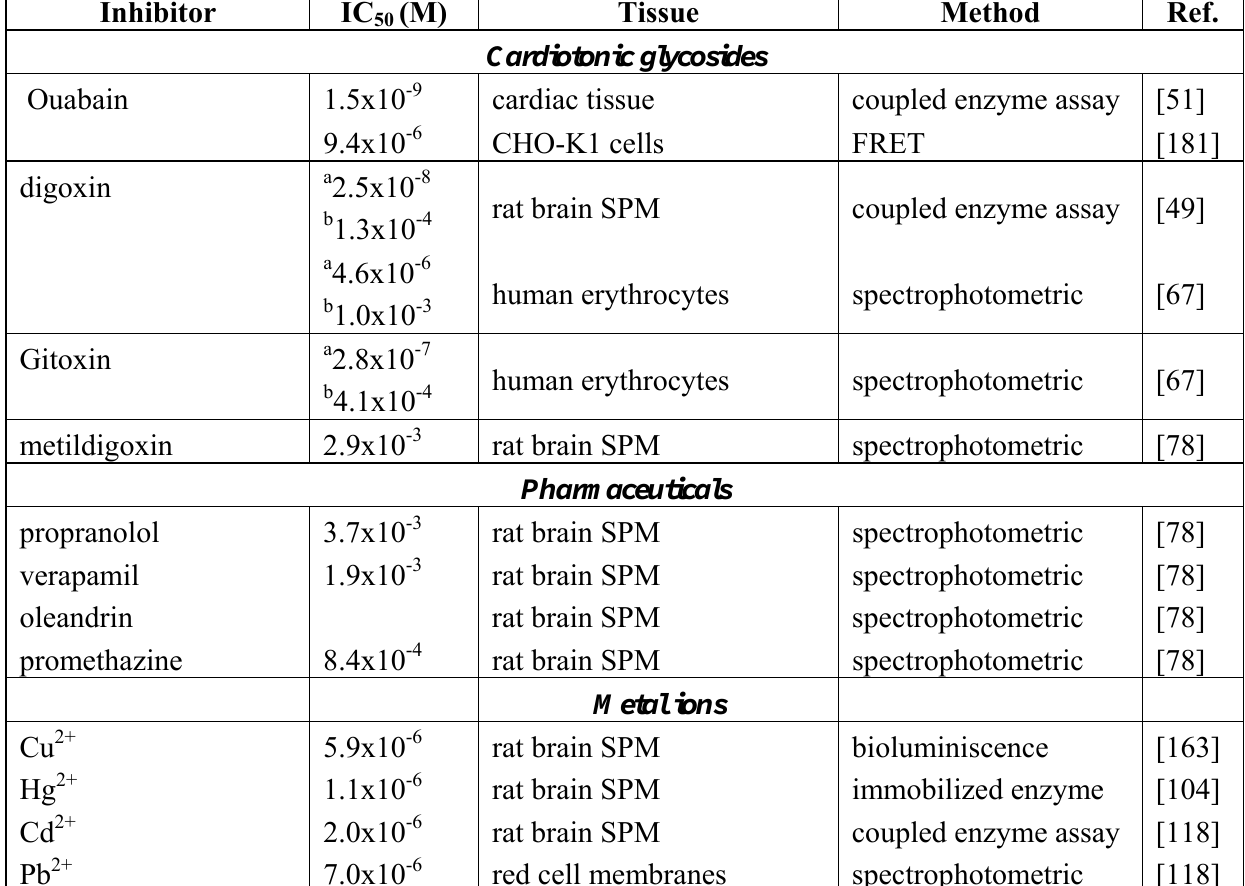
for the representative of some characteristic groups of sodium pump 50